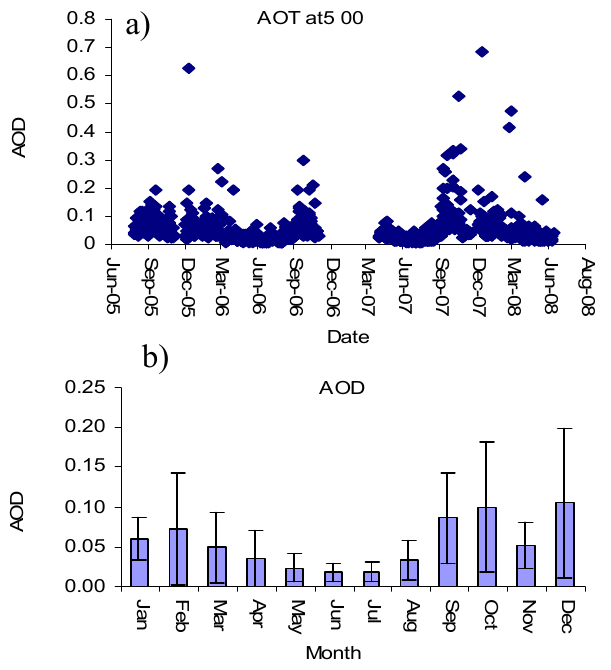
Fig. 2. (a) Daily means of AOD at 500nm from August 2005–June 2008. (b) Monthly means and standard deviations of AOD for same period. Fig. 3. (a) Daily means of α (440–870nm) from August 2005–June